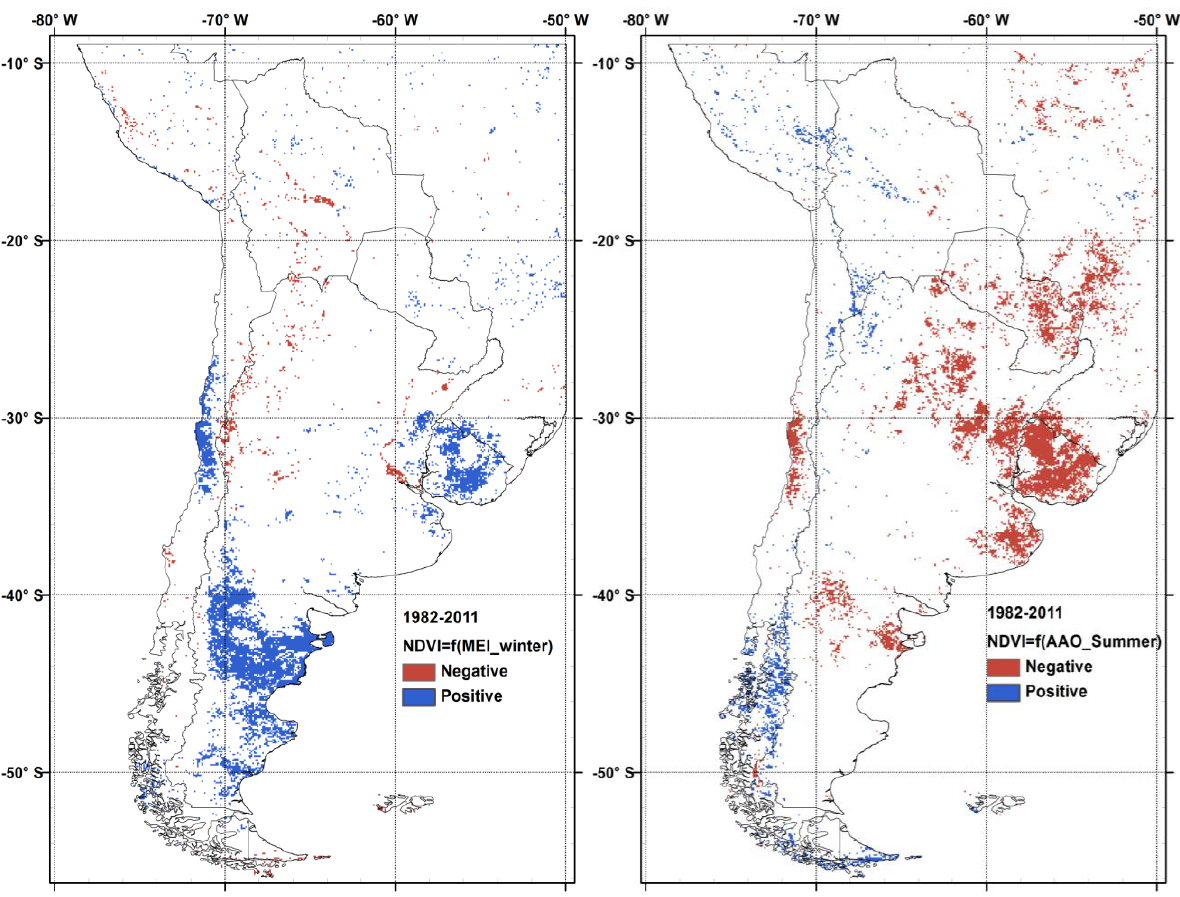
Figure 11. Annual Mean NDVI values (1982–2011) are responding most strongly to winter MEI and summer AAO data ( p ≤